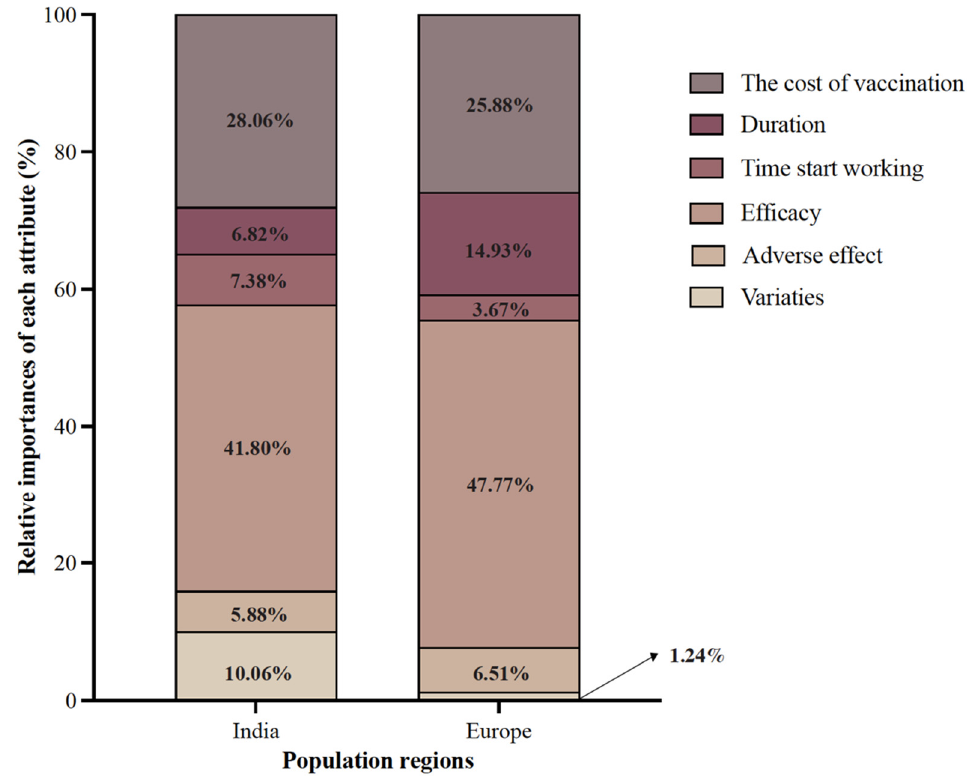
Figure 2. The Relative Importance of COVID-19 Vaccine Attributes: Comparison between Respondents from India and European Countries.